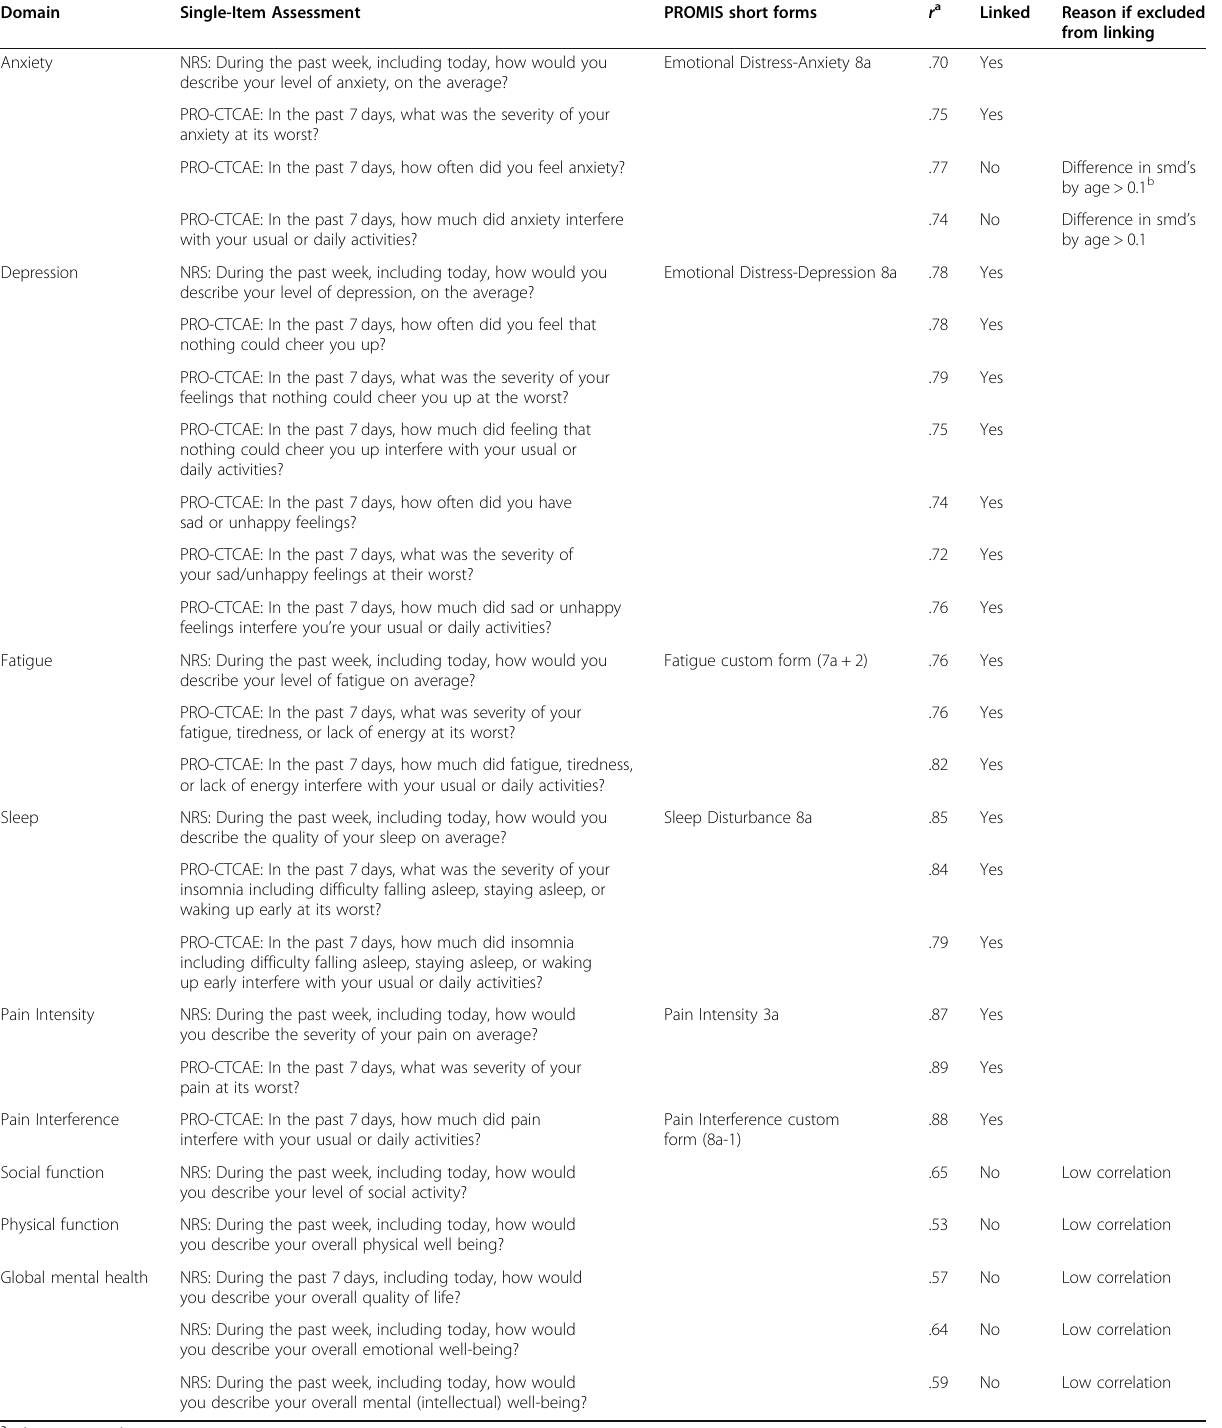
Table 2 List of Domains and Measures Considered for the Linking